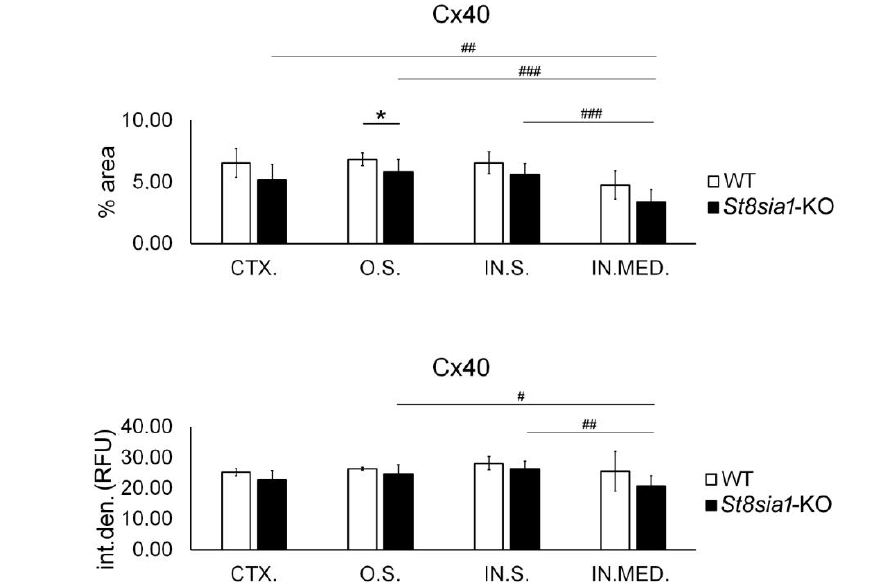
Figure 4. Expression of connexin 40 in different renal parts of the wild type and St8sia1 -KO mice. WT—wild-type mice; St8sia1 -KO— St8sia1 knockout mice; CTX.—cortex; O.S.—outer stripe of outer medulla; IN.S.—inner stripe of outer medulla; IN.MED.—inner medulla; % area—percentage of sectional area occupied by Cx40 immunofluorescence; int.den. (RFU)—integrated density (relative fluorescence units). Column a—representative photomicrographs of the indicated kidney section areas stained with Cx40 (green) and alpha-smooth actin (red) antibodies; cell nuclei are stained in blue. Column b—(same section as a) processed and thresholded photomicrographs prepared for analysis (inverted black for white on thresholded green image). Statistically significant difference between WT and St8sia1 - KO: * p < 0.05 ( t -test for unequal variances). Comparison between different kidney areas in the same group: WT—there was no significant difference; for St8Sia1 -# p < 0.05, ## p < 0.01, ### p < 0.001 (one-way ANOVA followed by Tukey’s test for dependent samples). Scale-bar = 20 µ m, refers to all (magnification 400 ×